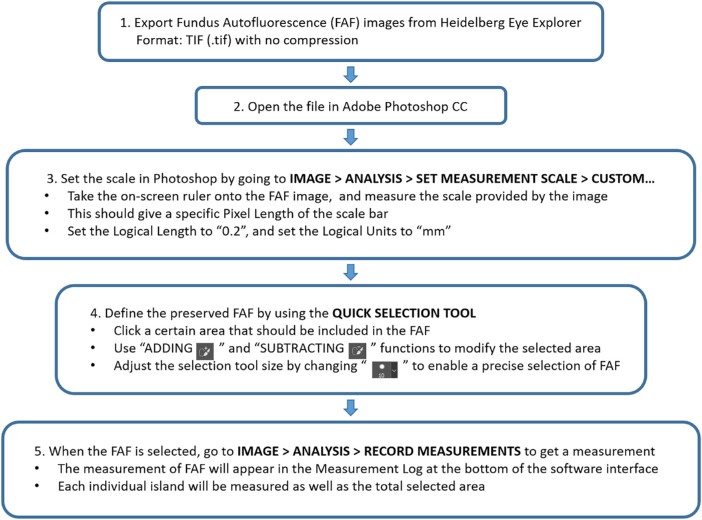
Preserved FAF Photoshop-based quantification methodology.